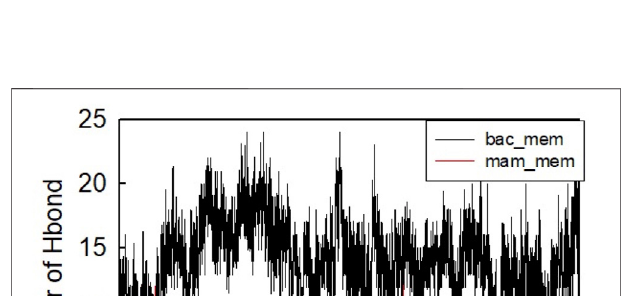
FIGURE 7 | Pairwise root mean-square deviation (RMSD) distribution of CaD23 in water and in mimetic bacterial and mammalian membranes. The RMSD values of CaD23 in water were high and widely distributed, suggesting that the conformation was highly fl exible and heterogeneous in water when compared to in mimetic membranes.